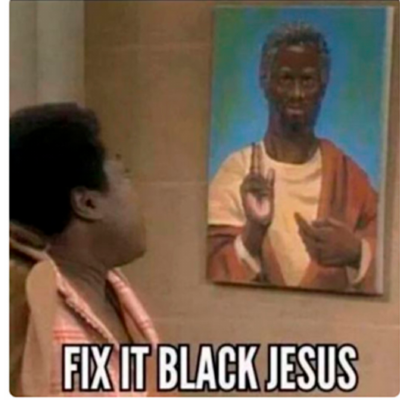
Figure 4. “Fix it Black Jesus”